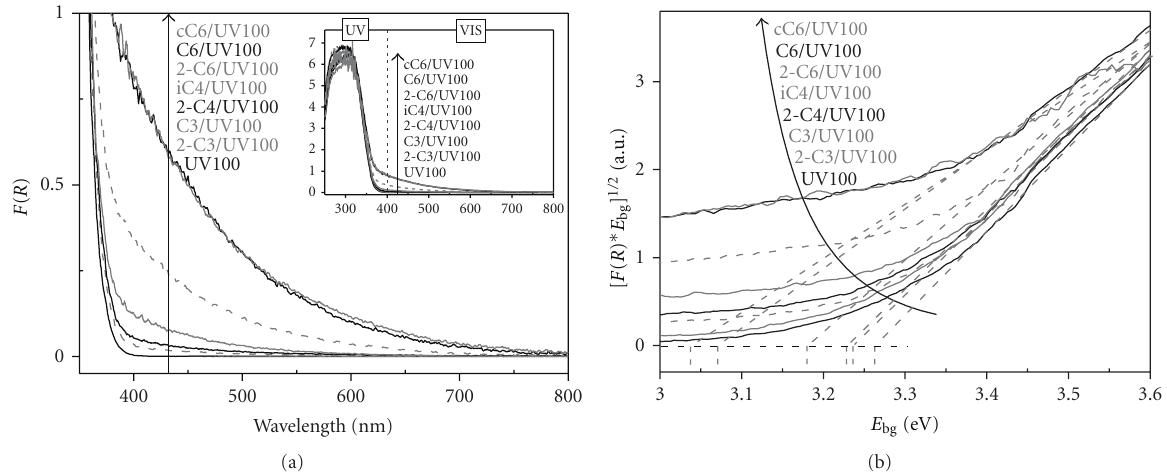
Figure 7: UV-visible absorption spectra (a) and the plot of transformed Kubelka-Munk function versus the energy band gap